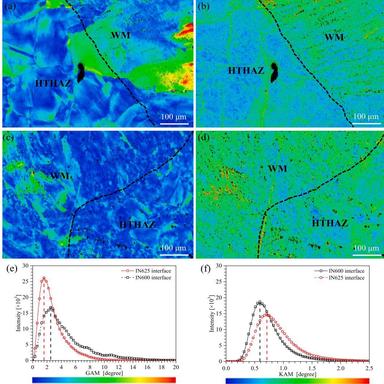
(left) GAM and (right) KAM misorientation maps of the fusion line/HTHAZ of (a-b) IN600, (c-d) IN625, and (e-f) corresponding histograms.